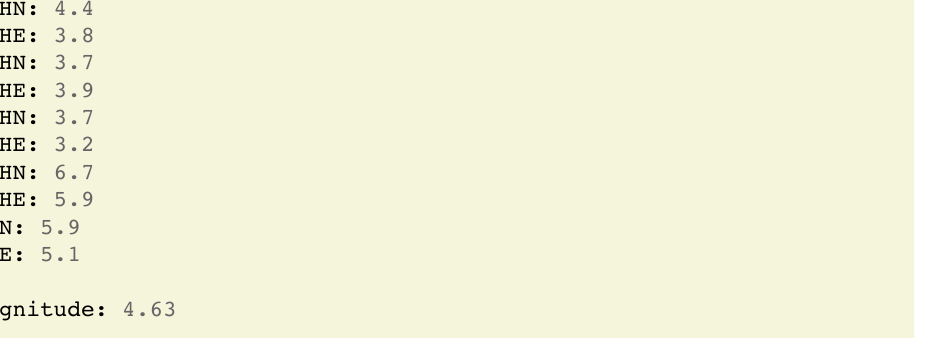
Figure 15. Example code: Output of code in Figure 14.